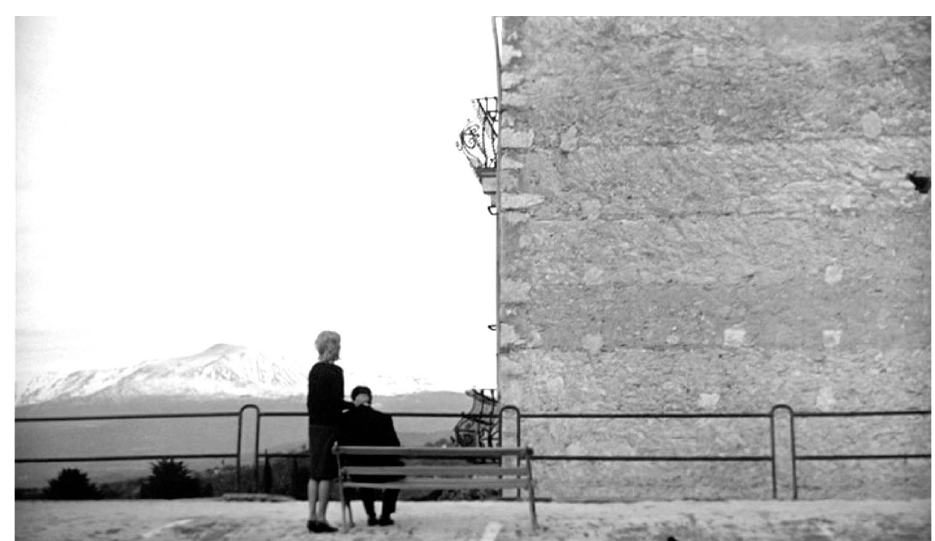
Figure 15 Sandro and Claudia in